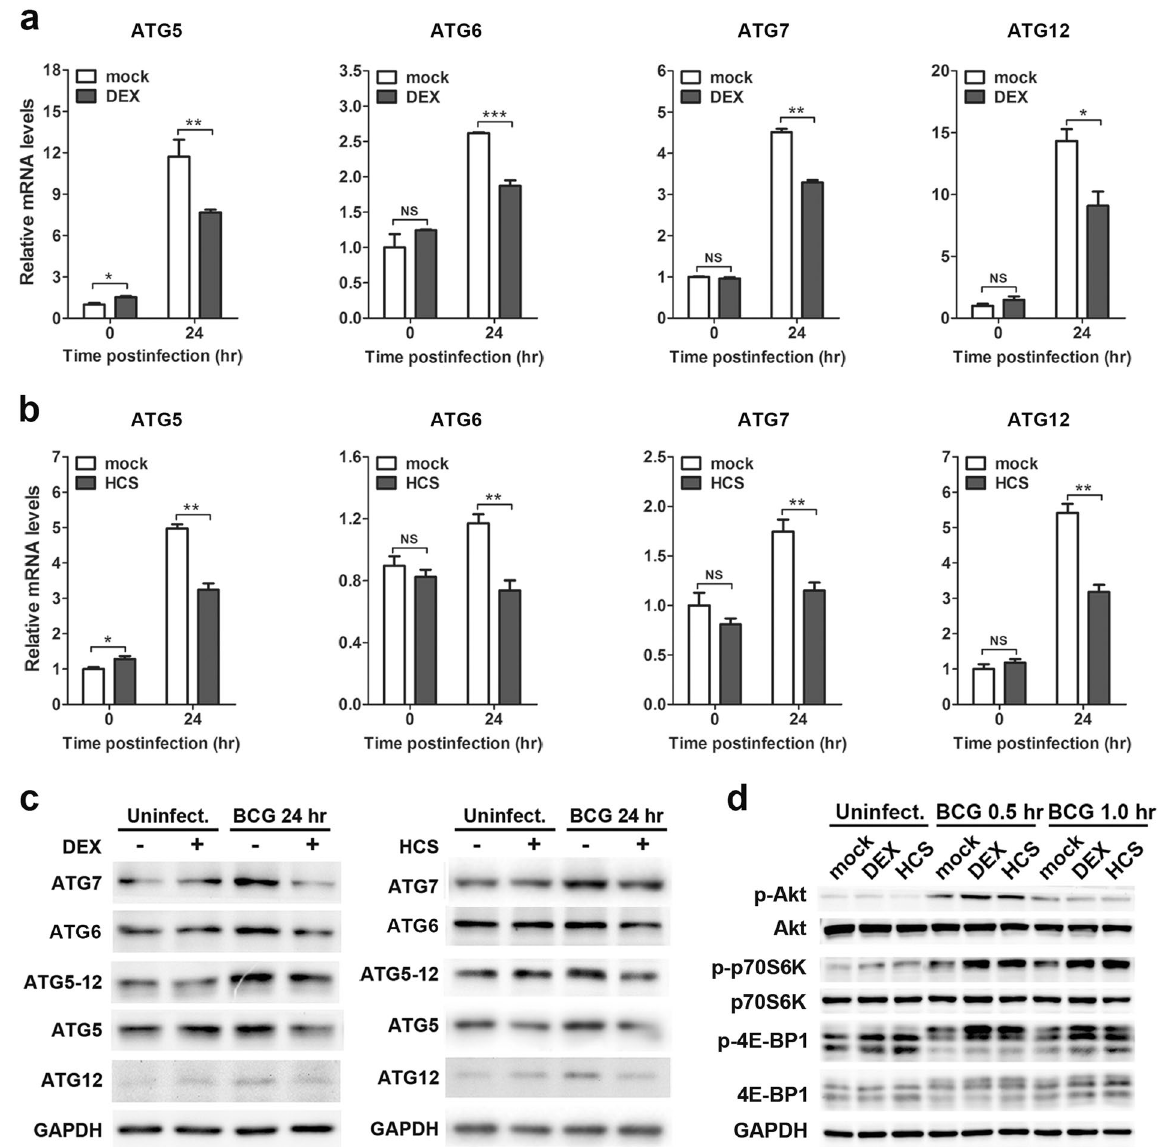
Figure 6. Glucocorticoids inhibit autophagy by suppressing the expression of ATGs and enhancing the activation of the Akt/mTOR pathway. ( a – c ) RAW264.7 cells were pretreated with dexamethasone (DEX) (1 μ M), hydrocortisone (HCS) (1 μ M) or vehicle control ethanol (mock) for 6 hr and then challenged with M. bovis BCG (MOI 5) for 24 hr. mRNA and protein levels of ATGs were determined by real-time PCR ( a , b ) and Western blot ( c ), respectively. Full-length blots are presented in Supplementary Fig. 10. ( d ) RAW264.7 cells were pretreated with DEX (1 μ M), HCS (1 μ M) or vehicle control ethanol (mock) for 24 hr and then challenged with M. bovis BCG (MOI 5) for the indicated times. Phosphorylation and total protein levels of the indicated genes were determined by Western blot analysis. Full-length blots are presented in Supplementary Fig. 11. For Western blotting, GAPDH was used as the loading control. Data are representative of three independent experiments with similar results. For real-time PCR, the level of each mRNA was normalized to that of β -actin mRNA and is expressed relative to expression in unstimulated cells. Data are shown as the mean ± SEM of three independent experiments. * p < 0.05; ** p < 0.01; *** p < 0.001. NS, not